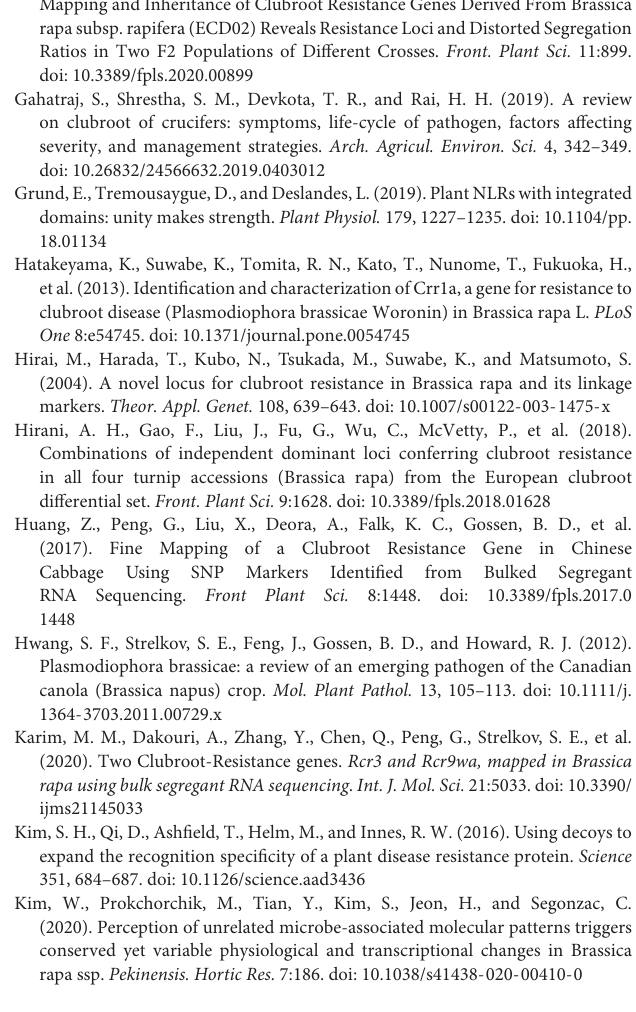
Supplementary Figure 3 | Protein sequence alignments of homologs of BraA08g039193E from DW, ECD04, Z1, ZS11, SL, and QU. Red solid lines represent the LRR domain. Supplementary Figure 4 | Protein sequence alignments of homologs of BraA08g039211E from DW, ECD04, Z1, ZS11, SL, and QU. Green solid lines represent the TIR domain, orange solid lines represent the NB-ARC domain, and red solid lines represent the LRR domain. The symbol “ ∗∗ ” indicates the two missing residues in DW compared with other accessions. The symbol “ ∗ ” represents the specific residues in DW. Supplementary Figure 5 | Protein sequence alignments of homologs of BraA08g039212E from DW, ECD04, Z1, ZS11, SL, and QU. Green solid lines represent the TIR domain, orange solid lines represent the NB-ARC domain, and red solid lines represent the LRR domain. The symbol “ ∗ ” represents the specific residues in DW. Supplementary Table 1 | Primers used in this study. Supplementary Table 2 | Quality control of BSA sequencing